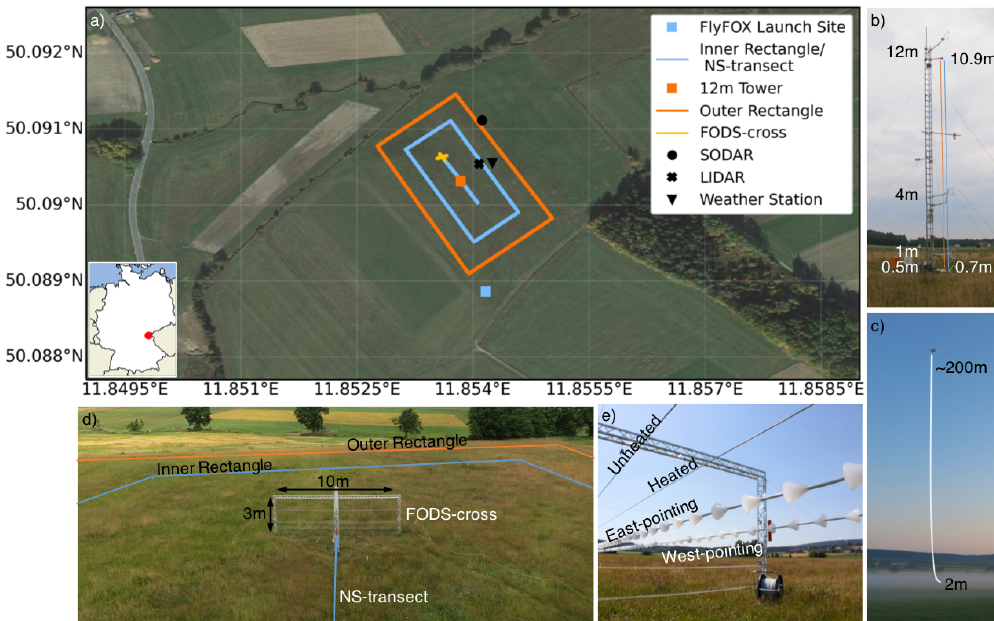
Figure 2. (a) A map of all components of LOVE19 except for the ceilometer which was approximately 400m to the northeast (not shown). FODS components with active heating for wind speed are shown in orange (outer rectangle and the 12m tower); FODS components without heating are shown in blue (NS transect and inner rectangle), and the FODS cross is in gold. (b) The 12m tower with CSATs and the paired heated–unheated fiber-optic cables viewed from the east. (c) FlyFOX on 18 July, a morning with fog discussed in Sect. 6.1, viewed from the top of the hill to the south. (d) The outer rectangle with paired heated–unheated fiber-optic cables (orange), the inner rectangle (blue), FODS cross (aluminum trussing), and the NS transect as viewed from the top of the 12m tower. (e) The fiber quartet of the FODS cross, consisting of paired heated–unheated and paired heated fibers, with microstructures oriented in opposite directions shown in more detail. To better highlight the fiber-optic cables, they have been drawn onto images in (b) – (d) . Map data © Google 2021, map imagery © GeoBasis- DE/BKG 2021, GeoContent, and Maxar Technologies.